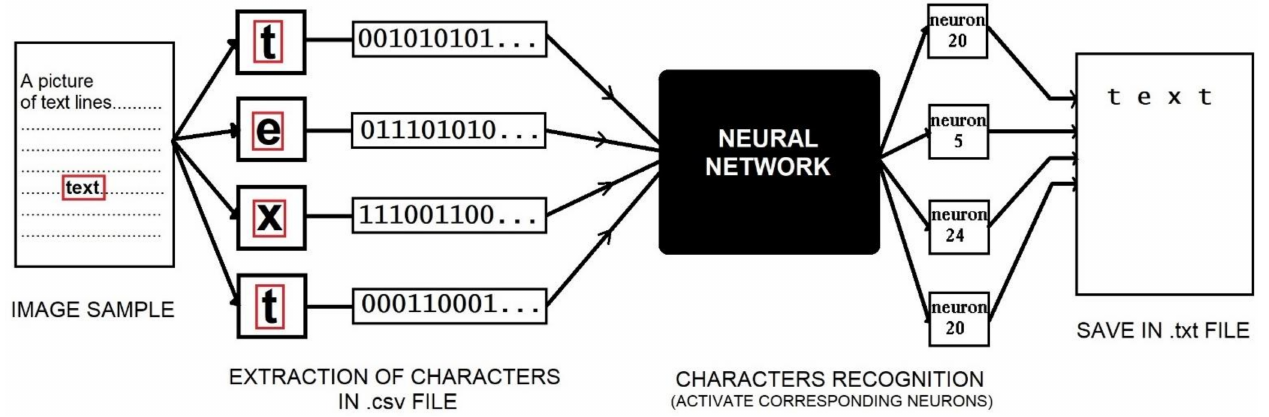
Figure 13. Basic schematic operation of the